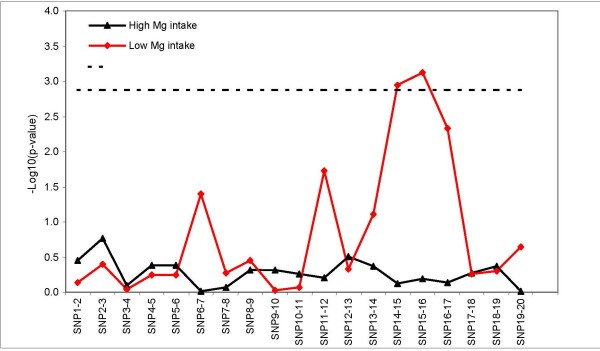
Sliding window analysis for haplotype-disease associations. Haplotype was reconstructed by 2-SNP sets. The omnibus test was used for the TRPM6 haplotype-type 2 diabetes associations for each sliding window set. Empirical p-value was based on permutation test. The dashed line represents a -log10P value of 2.88 (corresponding to P = 0.0013), which was used as the global significance threshold by Bonferroni correction for 19 window frames.